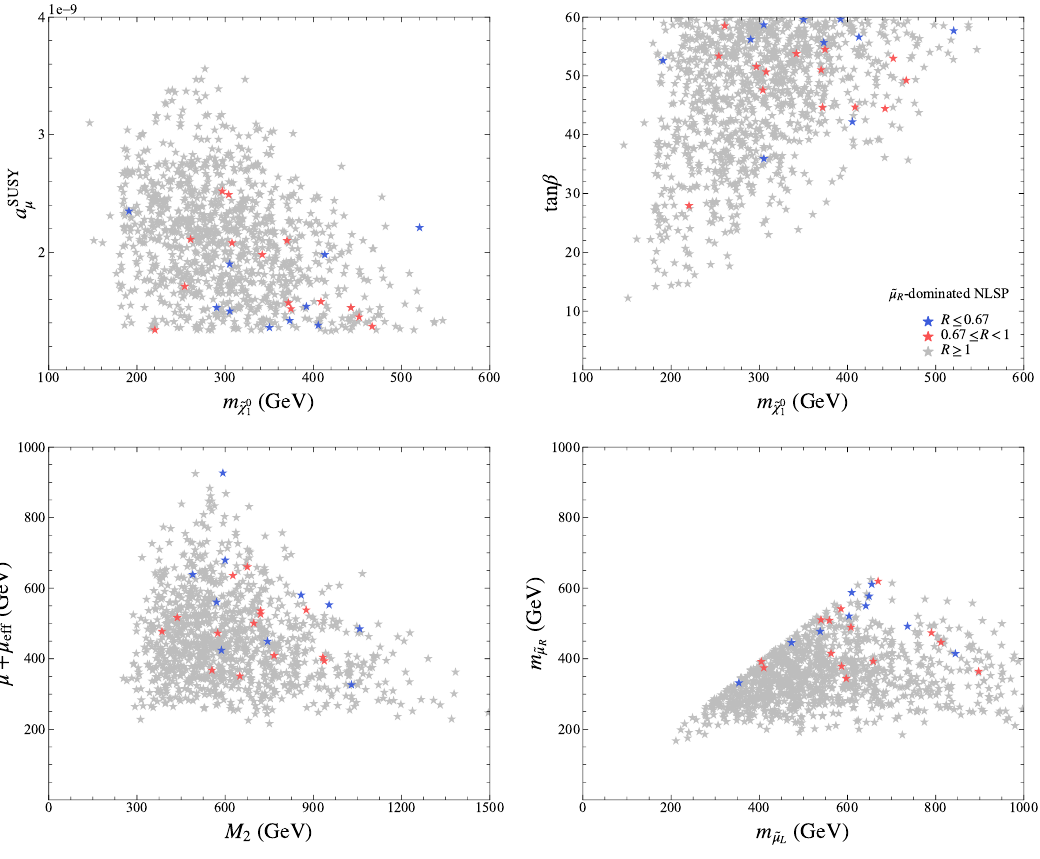
Figure 5 . Similar to figure 4, but for the samples with ˜ µ R -dominated